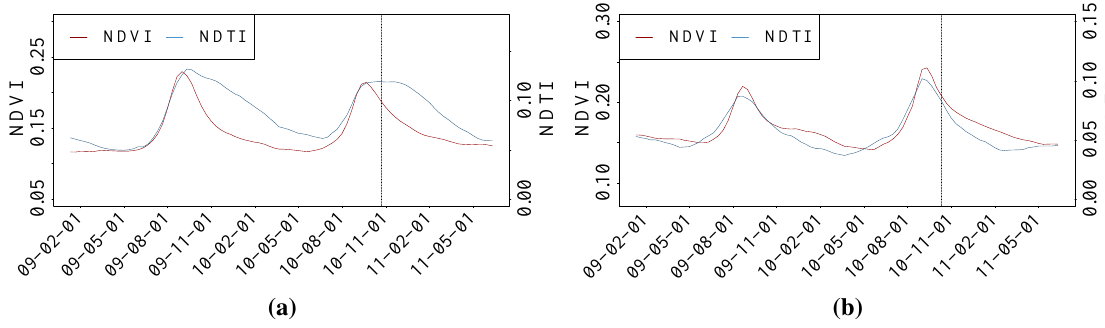
Figure 2. Smoothed temporal profiles of NDVI and Normalized Difference Tillage Index (NDTI) (2009–2011). (a) Drying vegetation without density reduction (shown by the black vertical line). (b) Drying vegetation with density reduction (shown by the black vertical line). NDVI is only sensitive to photosynthetically-active vegetation, whereas NDTI is sensitive to both photosynthetically-active and -inactive vegetation, allowing one to distinguish drying vegetation with (b) and without (a) density reduction. The smoothing applied corresponds to that described in Section